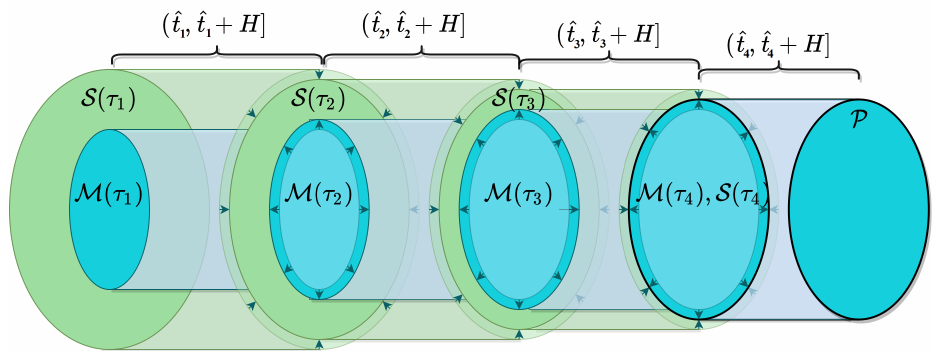
Figure 1. Deterministic tubes to the feasible sets of inner and outer problems over the prediction horizon for decreasing values of the approximation parameter τ 1 > τ 2 > τ 3 > τ 4